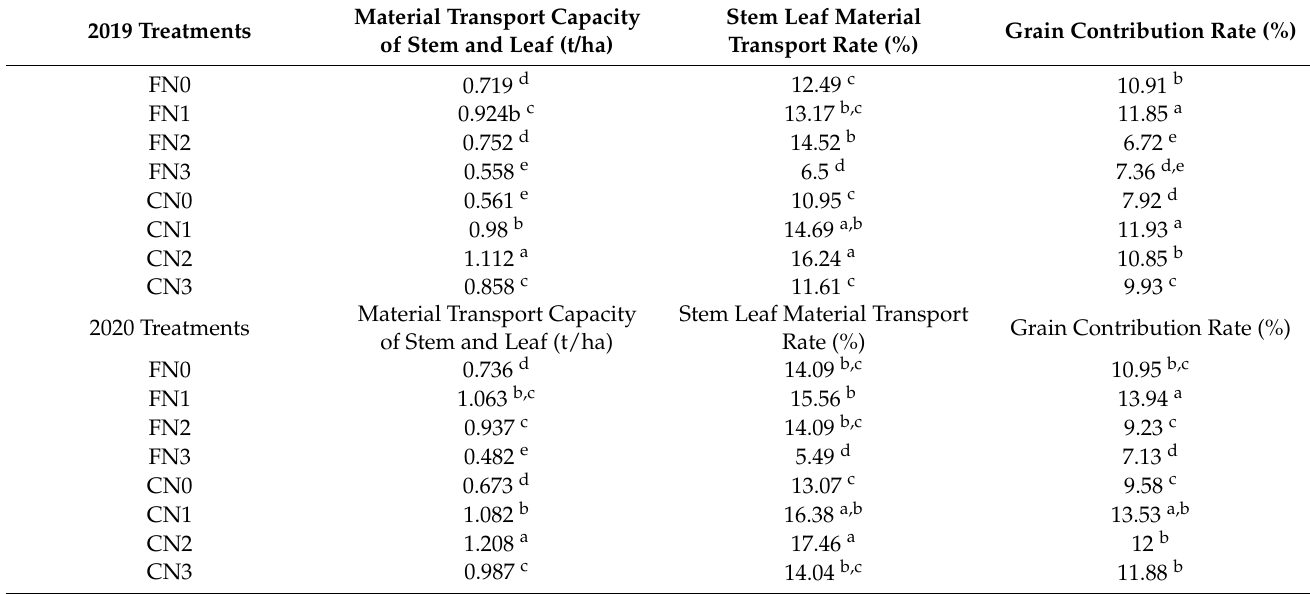
Table 4. The stem and leaf transport capacity, transport rate, and grain contribution rate of